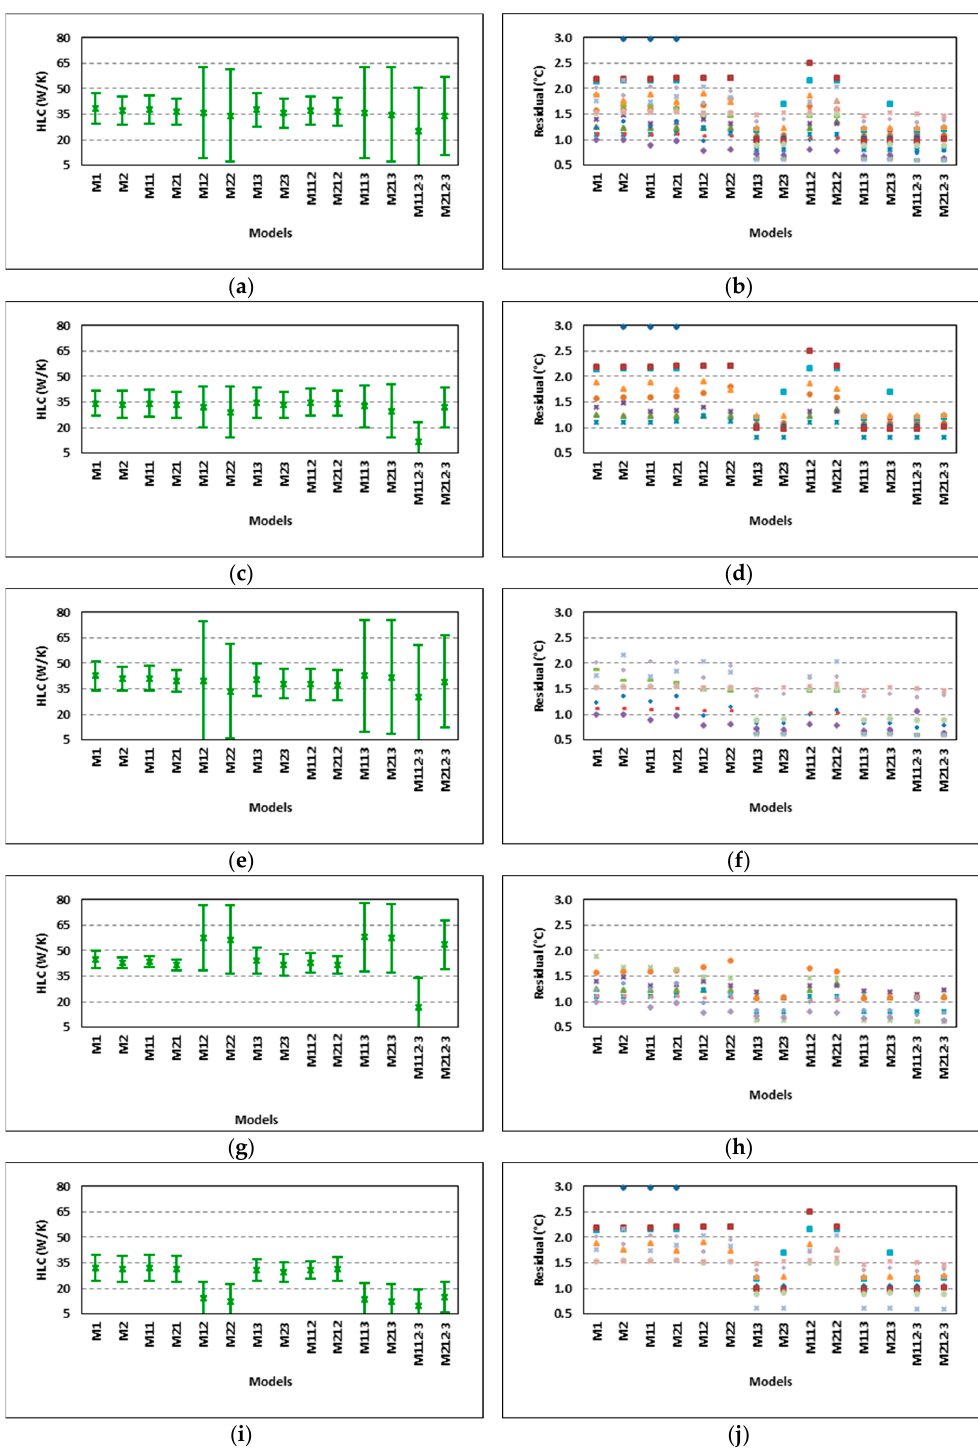
Figure 11. Summary of results. Left: HLC averaged for the considered data series and its uncertainty. Right: residuals from the considered data series and models. ( a , b ) all the series; ( c , d ) winter series; ( e , f ) summer series; ( g , h ) first-year series; ( i , j ) second-year